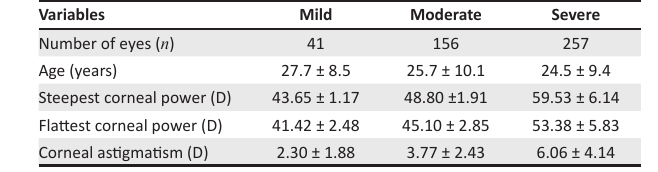
D, dioptre. FIGURE 1: Age distribution of the study sample.